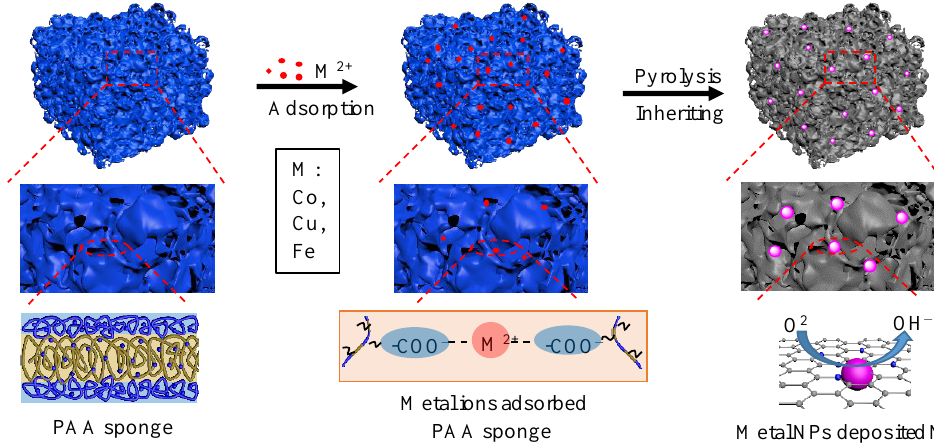
Figure 1. Schematic illustration of the preparation of M@NCS derived from the direct pyrolysis of metal ions that adsorbed PAA sponge for efficient ORR catalysis.